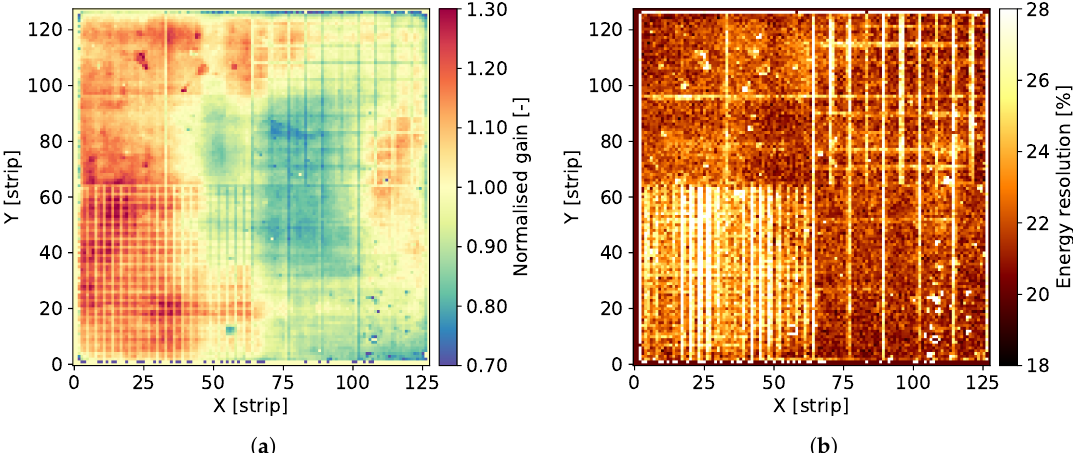
Figure 16. GEM detector D . 2D maps of: ( a ) normalized gas gain; and ( b ) energy resolution for detector bias voltage of 3770V.